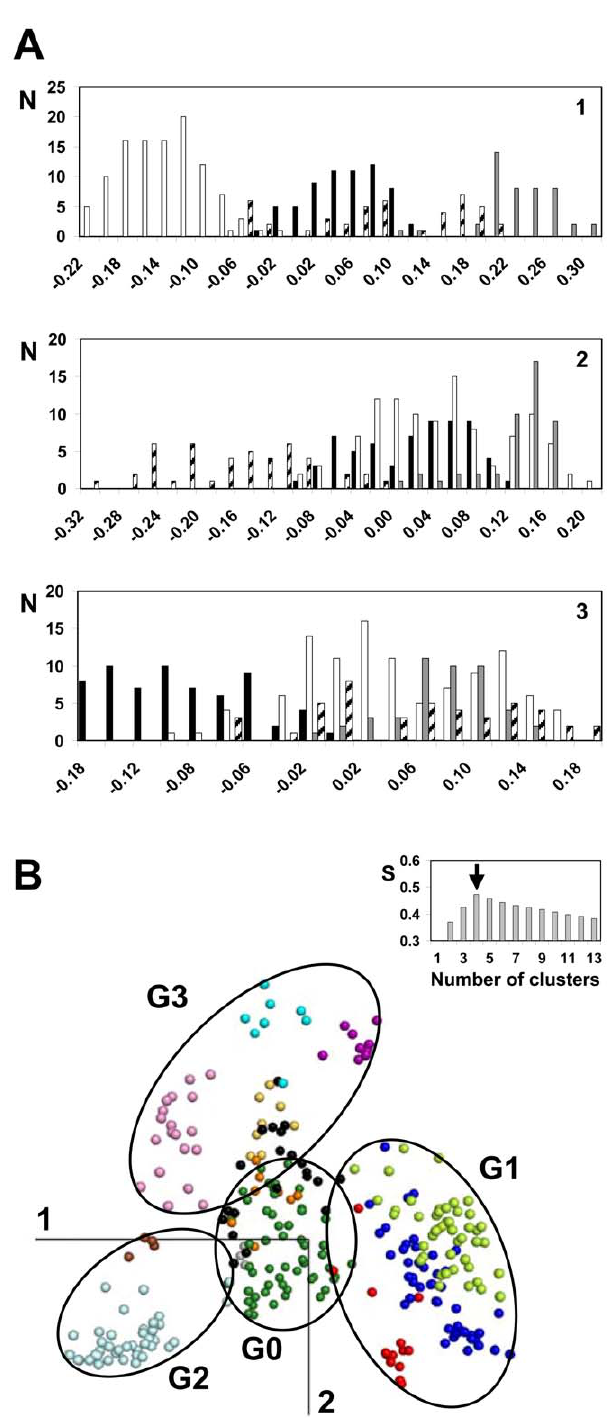
Figure 3. Clustering of human GPCRs. In (A), the histograms show the distribution of the receptors from groups G0 (black bars), G1 (white bars), G2 (grey bars) and G3 (hatched bars) as a function of their coordinates on the first, second and third components (from top to bottom). In (B), the four clusters obtained by K -means analysis are visualized by spanning ellipses onto the plane formed by the first two components. The insert displays the Silhouette score S obtained for K - means clustering as a function of the number of clusters. The color code refers to the GPCR sub-families (AD: brown; AMIN: light blue; CHEM: dark blue; LGR: yellow; MEC: pink; MTN: grey; MRG: violet; OPN: orange; PEP: dark green; PTG: cyan; PUR: light green; SO: red; UC: black).